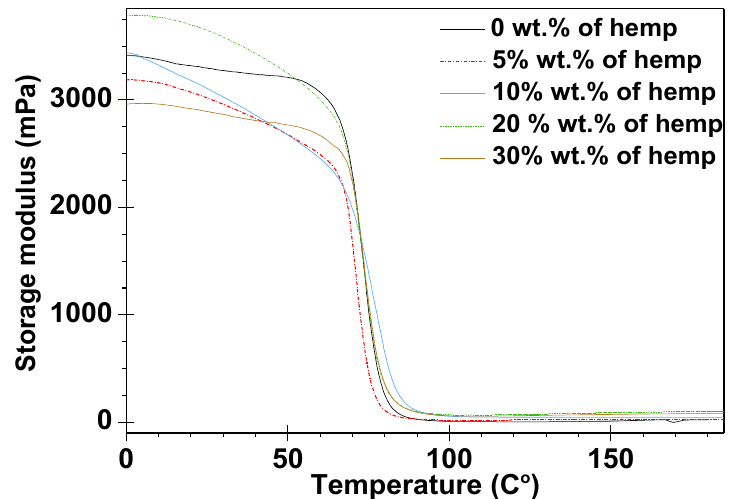
Polymers 2021 , 13 , x FOR PEER REVIEW 12 of 18